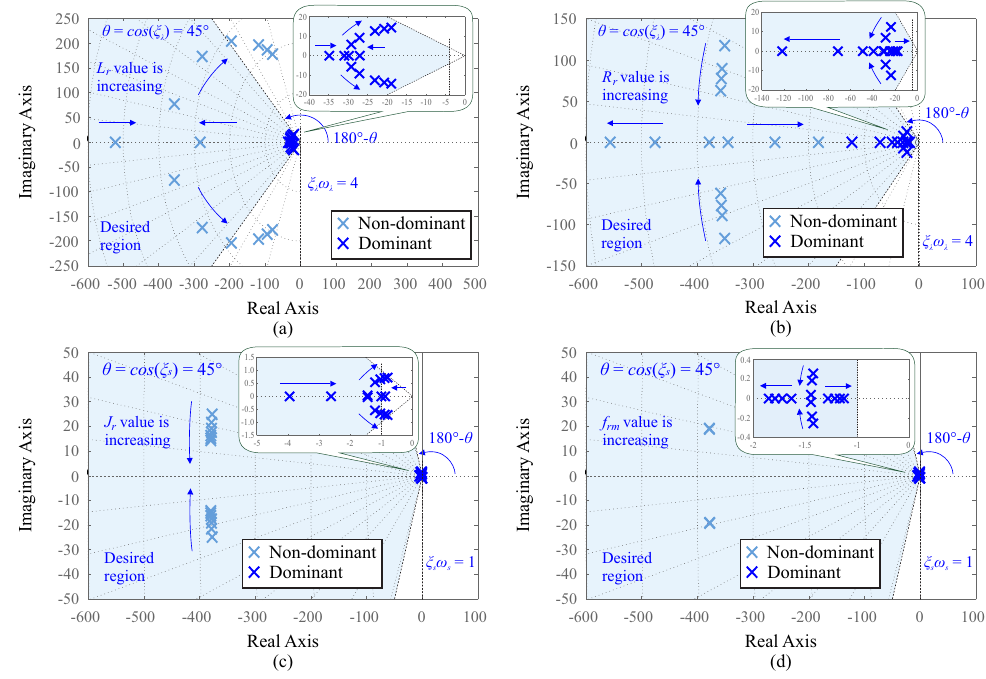
Figure 13. Closed-loop poles for ( a ) flux control when L r varies, ( b ) flux control when R r varies, ( c ) speed control when J r varies and ( d ) speed control when f rm varies.